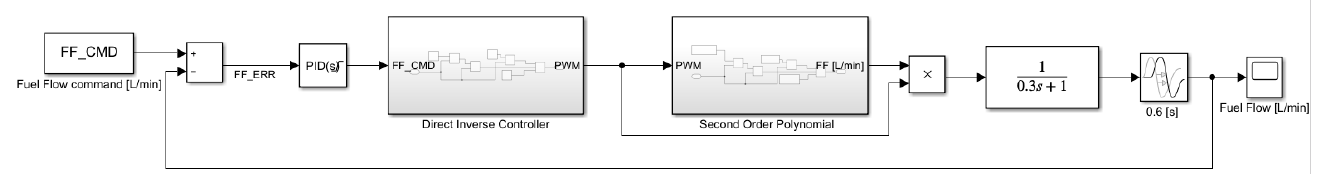
Figure 8. Implementation of the PID controller in simulation environment.